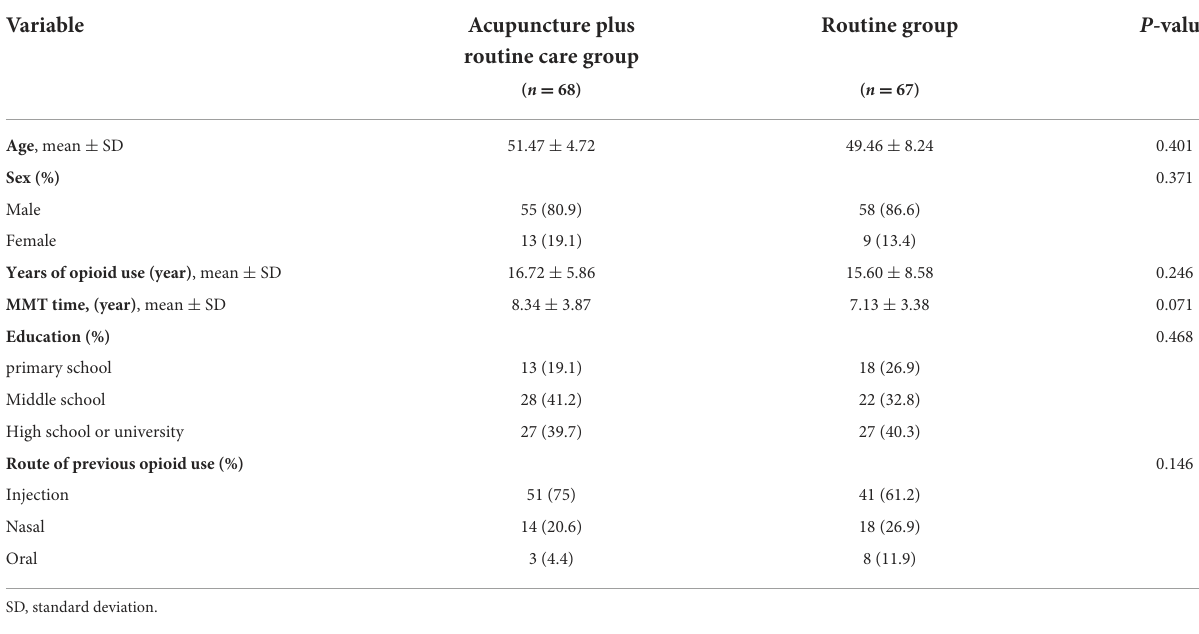
TABLE 1 Baseline characteristics of the study.